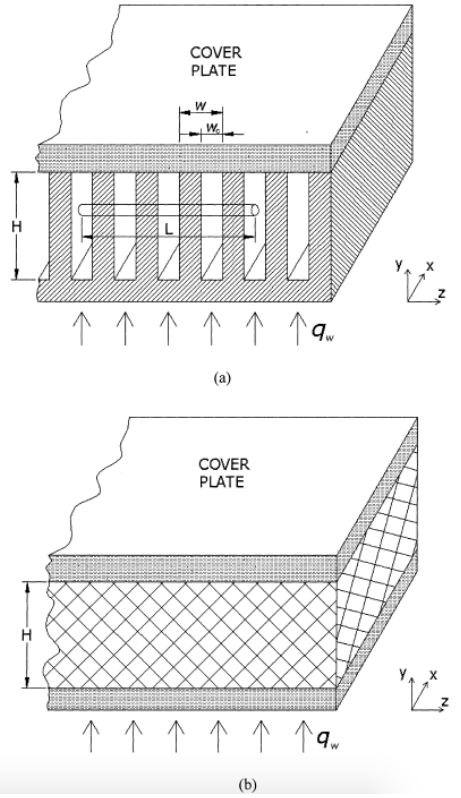
Figure 9. Kim et al. [38] modelled a ( a ) micro-channel as a ( b ) porous medium.